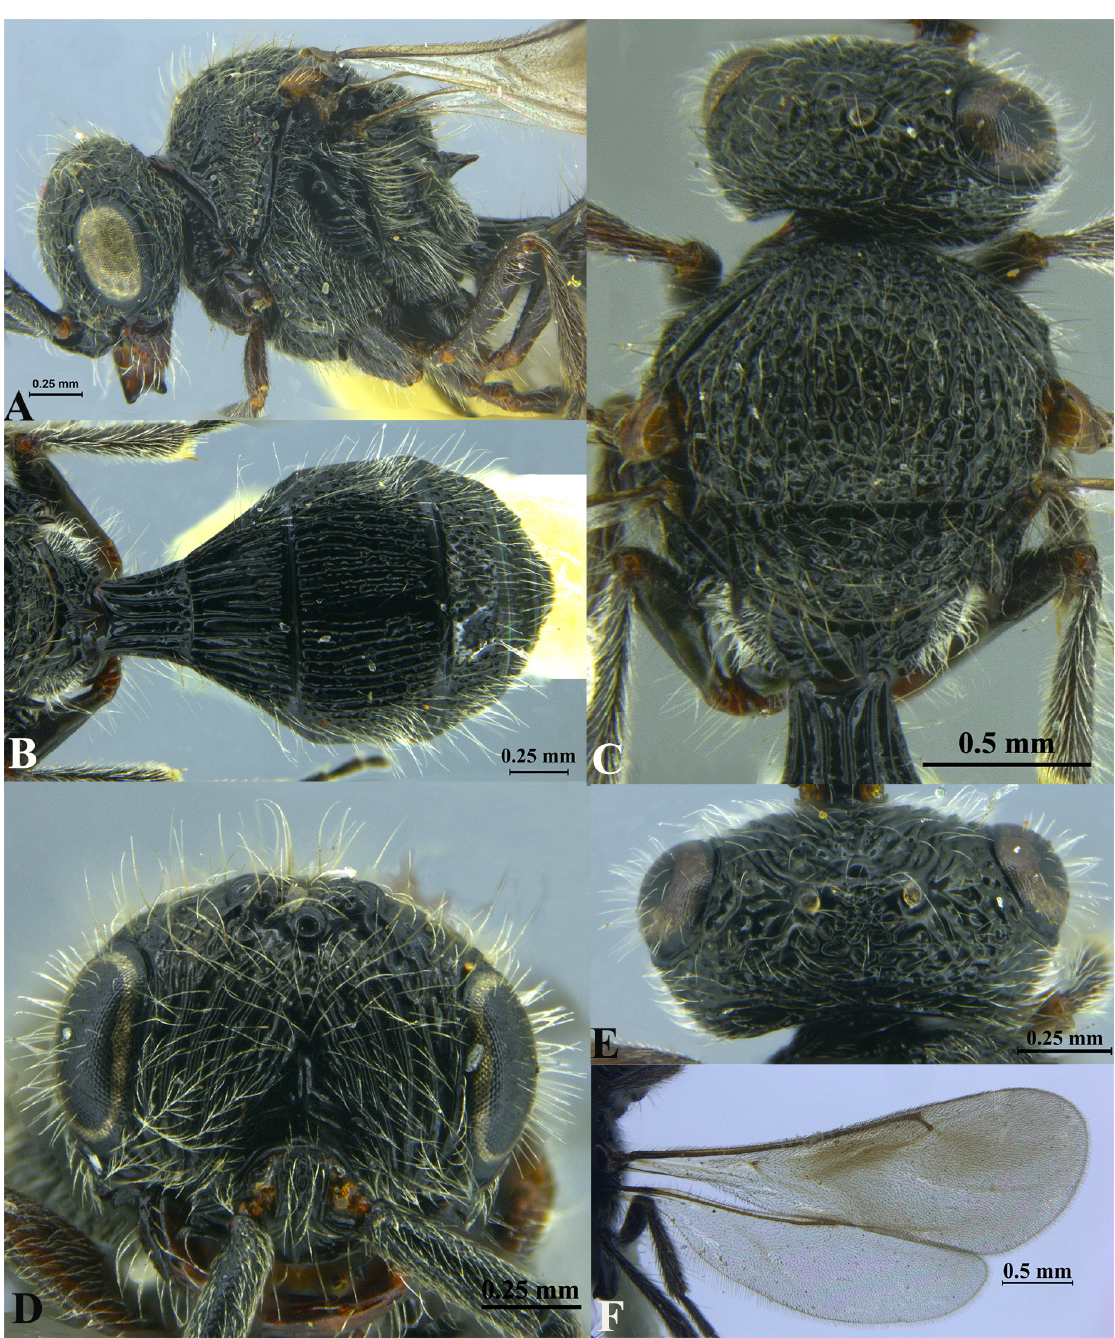
Fig. 20. Odontoscelio vikata Veenakumari & Rajmohana, 2011. Paratype, ♂ (ICAR-NBAII P3). A . Head and pleuron. B . Metasoma. C . Head and mesonotum. D . Frons. E . Vertex. F .